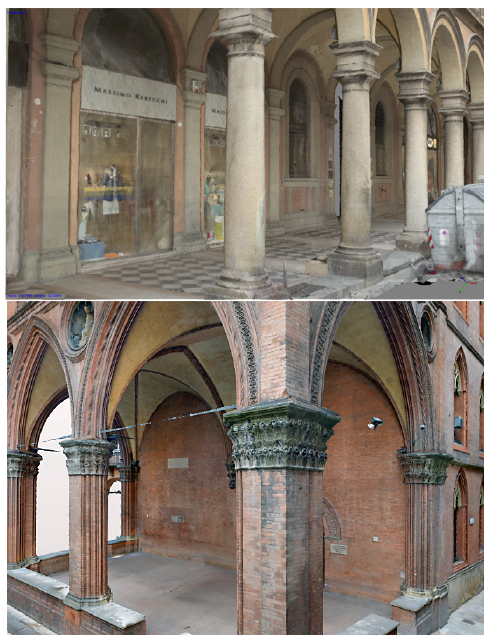
Figure 1. Examples of image-based 3D reconstruction results of complex architectural scenarios achieved with the presented methodology. achieved with the presented methodology.